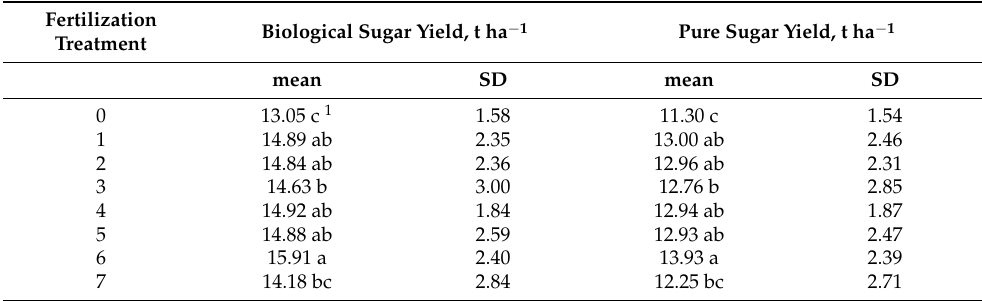
Table 3. Means and standard deviations (SD) of sugar yield of sugar beet (from 2018 to 2020). Fertilization Treatment